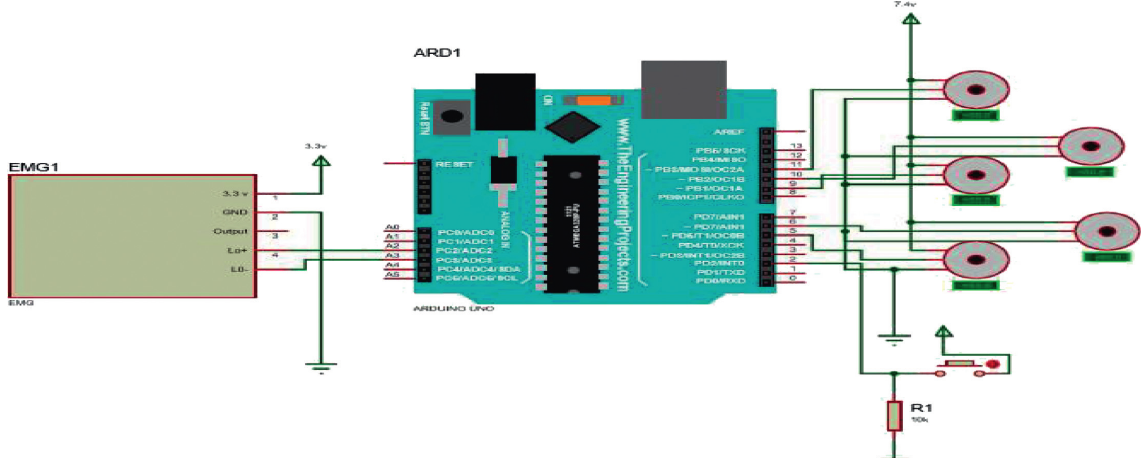
Figure 5: Electrical circuit configuration of the prosthesis.